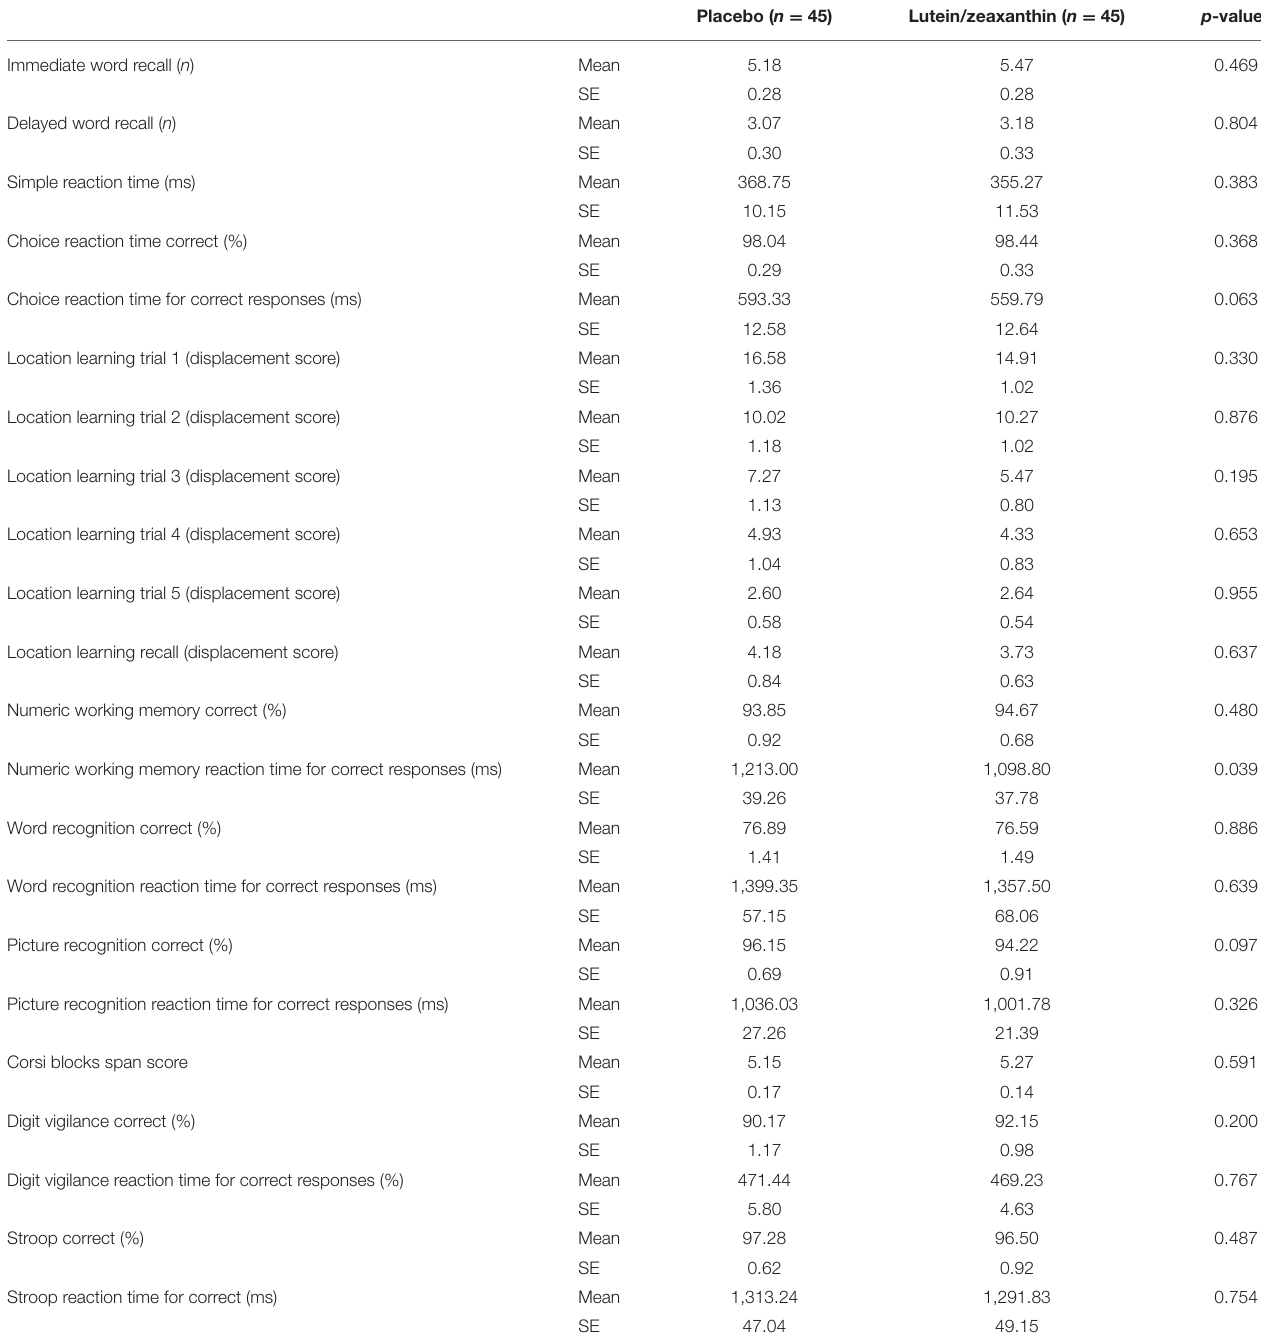
TABLE 3 | Baseline COMPASS